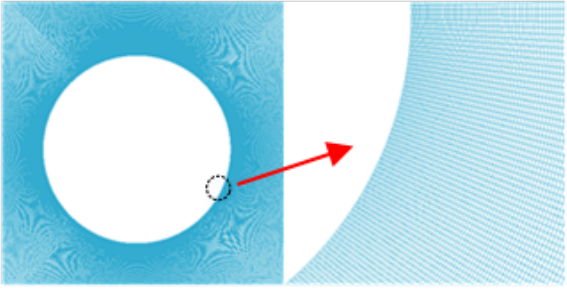
Fig. 3. Mesh of the positive feeder